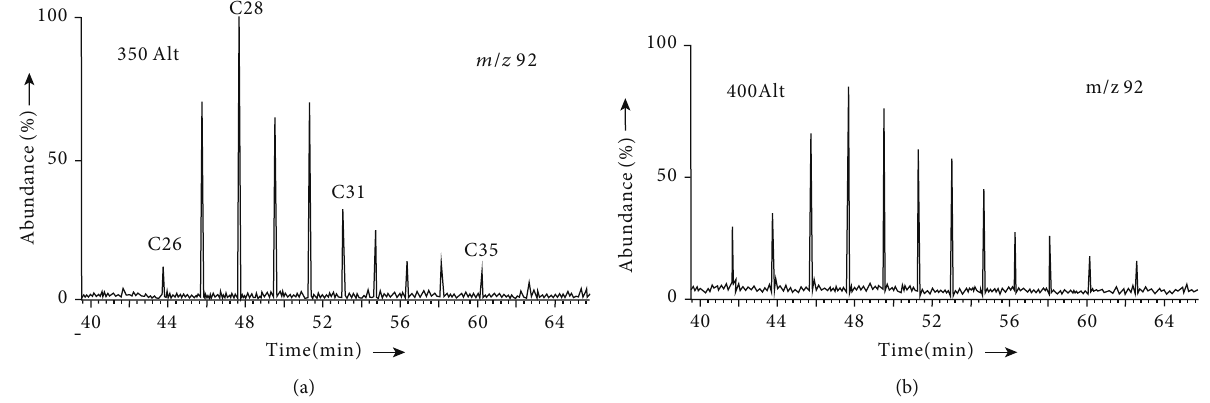
Figure 1: Molecular distributions of long-chain alkylbenzene in the 350Alt (a) and 400Alt (b) samples. Table 2: Parameters of long-chain alkylbenzenes in the pyrolysis samples.